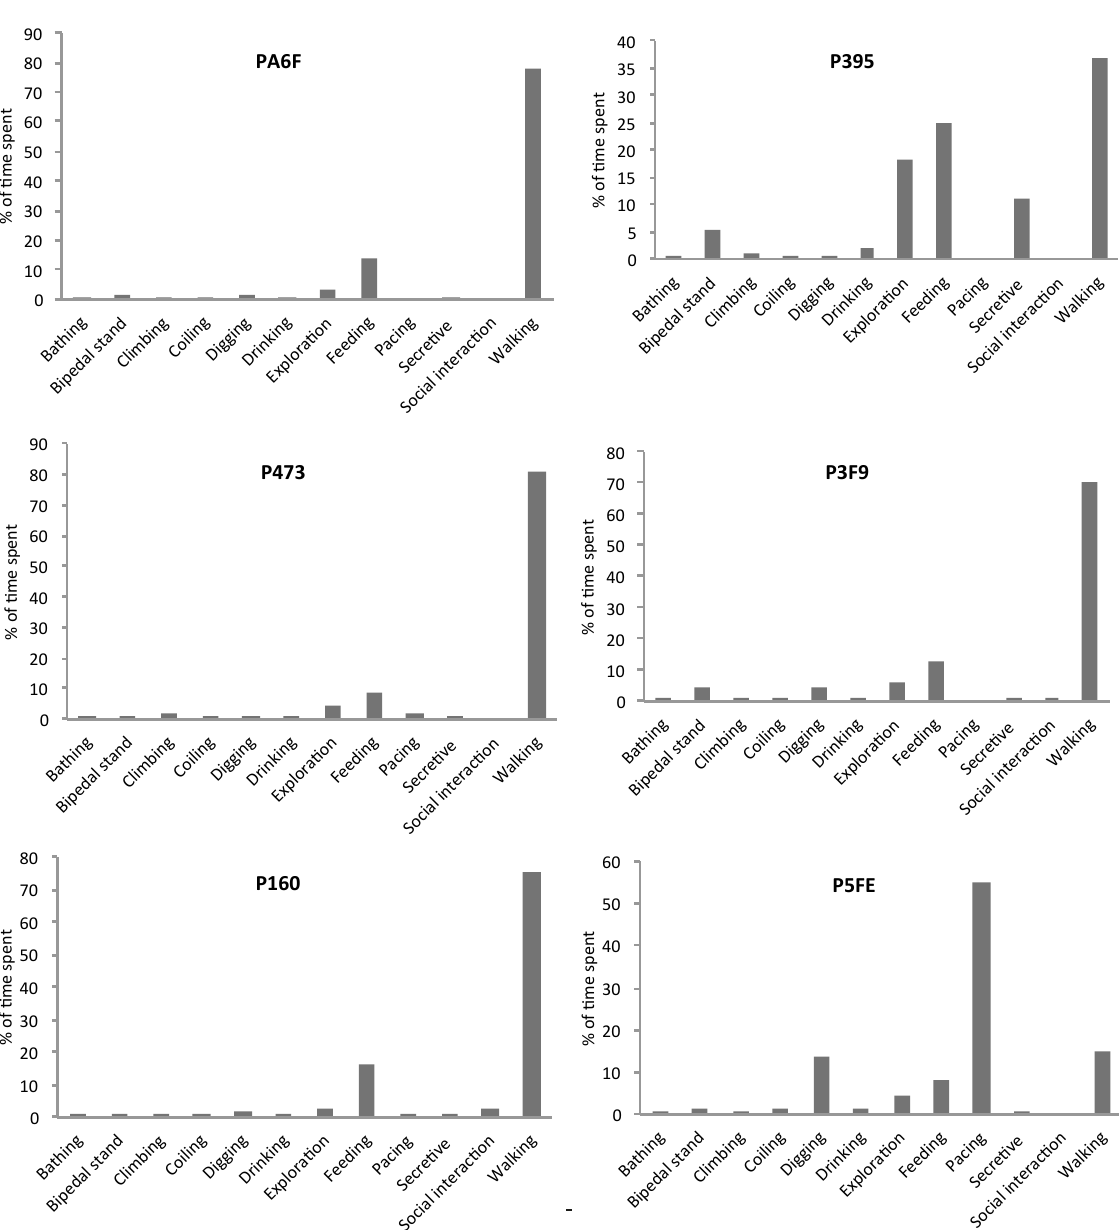
Figure 2. Mean time allocation in different behaviours in individual Indian Pangolins at captivity. Data presented here refer to Table 3. Behaviour types refer to description in Table